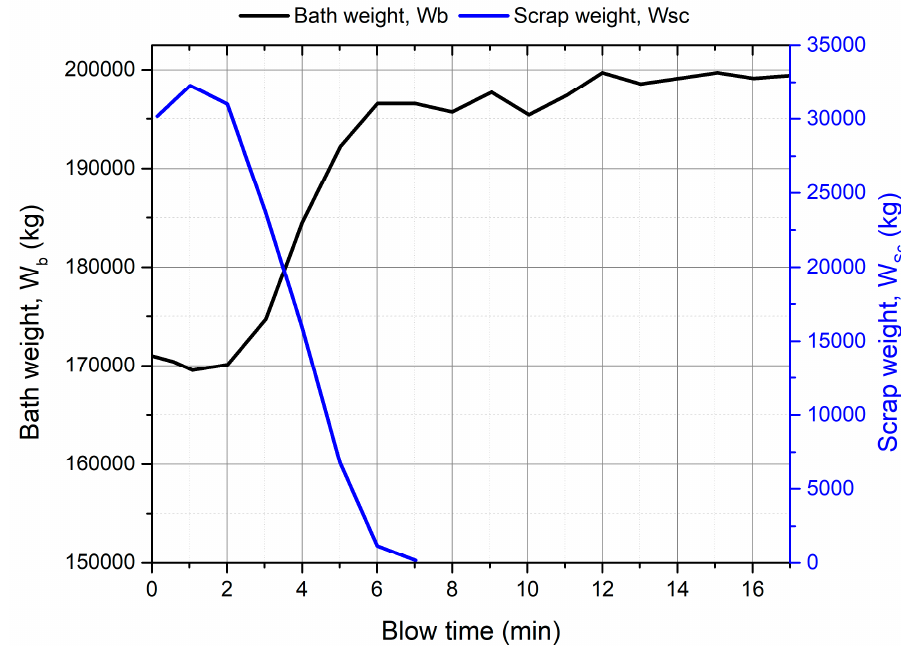
Figure 8. Bath and scrap weight changes for Cicutti et al.’s [4,5] operation.